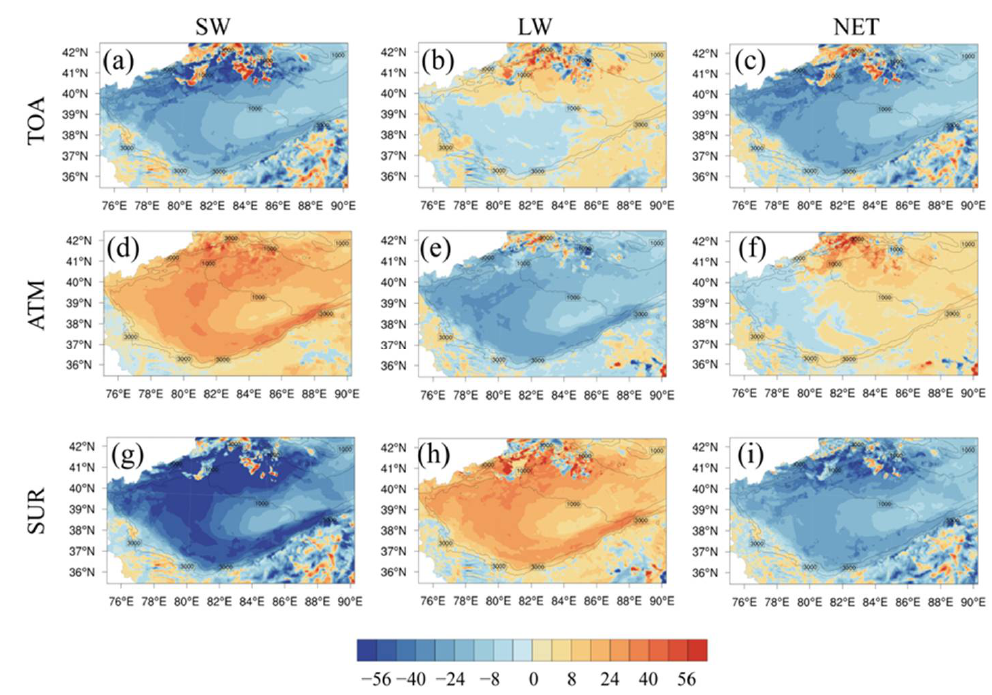
Figure 7. Spatial distributions of the mean SW, LW, and net (SW + LW) DDREs in W m −2 over the TB (a),(b),(c) at the top of the atmosphere (TOA: top panels), (g),(h),(i) at the surface (SUR: bottom panels), and (d),(e),(f) in the atmosphere (ATM: middle panels) on 30 April 2015, at 01:00 UTC. The DDRE at the TOA was influenced not only by the spatial distribution of aerosols, but also by surface albedo, cloud cover, and aerosol optical properties; however, there was no simple corresponding relationship with the distribution of the dust column load. Figure 7 shows that there were negative SW and net DDREs at the TOA during the daytime, and their spatial distribution characteristics were similar to those of the dust column concentrations (Figure 6). In the atmosphere, positive SW radiative effects and negative LW radiative effects were induced by dust through absorption. The heating rate induced by the DDRE has a major impact on the vertical distribu- tion of the atmospheric temperature. Figure 8 describes the vertical profiles of the heating rate induced by the DDRE at the (a) HT, (b) KEL, (c) KSH, and (d) TZH stations in the TB on 30 April 2015, at 01:00 UTC; as shown, dust was mainly concentrated below a 3 km